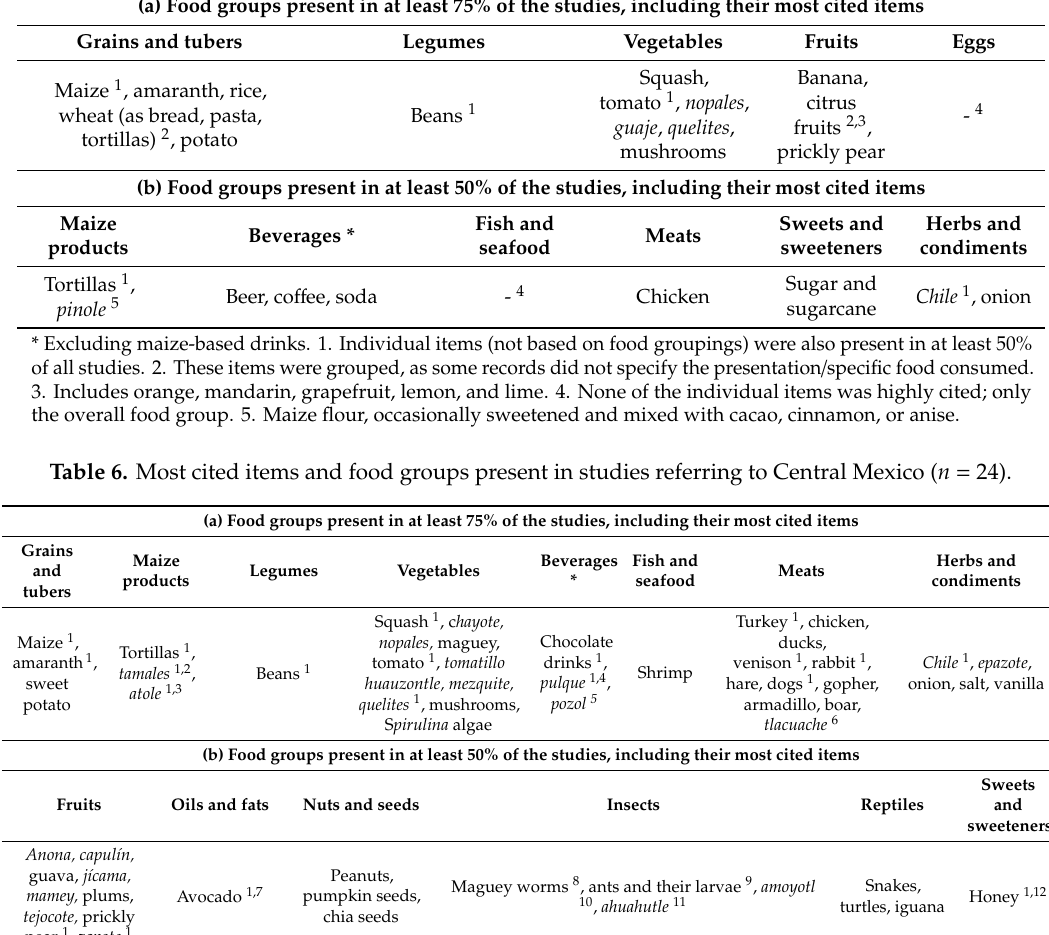
Table 5. Most cited items and food groups present in studies referring to Northern Mexico ( n = 7). (a) Food groups present in at least 75% of the studies, including their most cited items